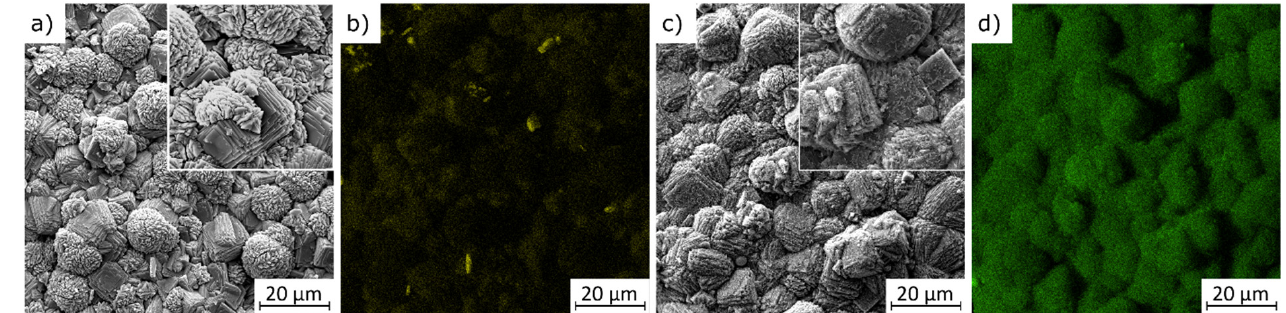
Figure 3. SEM images of zeolite aggregate doped with Cu 2+ ( a ) and Zn 2+ ( c ) ions and elemental distribution of copper ( b ) and zinc ( d ).